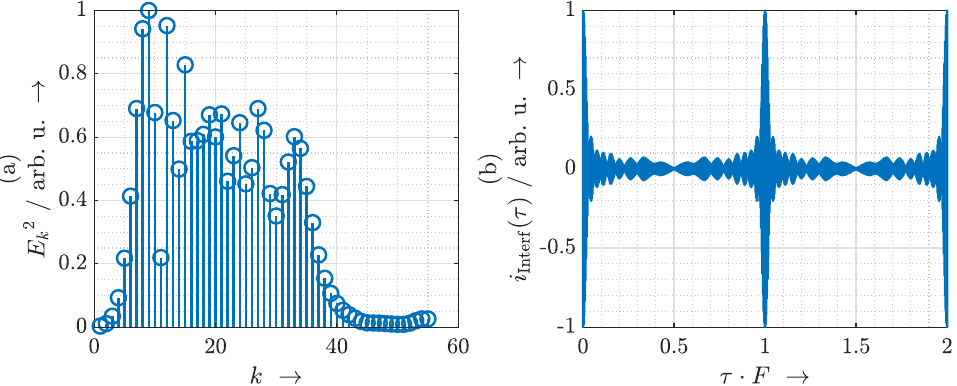
Figure 3. ( a ) Example of an optical spectrum. ( b ) Calculated interferometer signal for the exam- ple